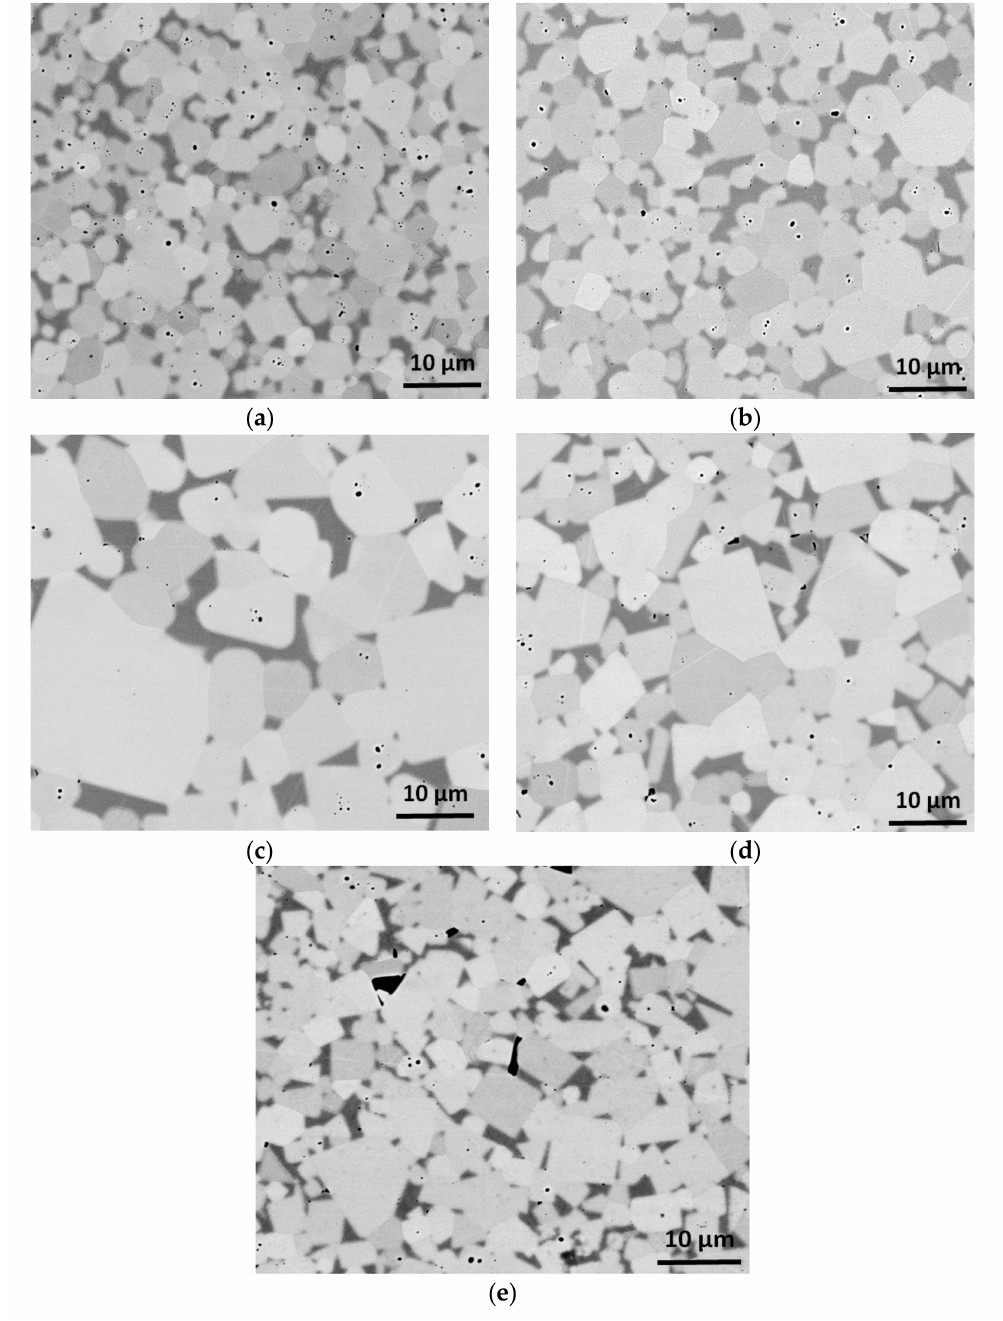
Figure 2. Influence of carbon content on the microstructure of the NbC-12 vol % Ni based cermets sintered for 1 h at 1420 ◦ C. ( a ) (NbC-4NbH 2 )-12Ni, ( b ) (NbC-2NbH 2 )-12Ni, ( c ) NbC-12Ni, ( d ) (NbC-2C)-12Ni and ( e )